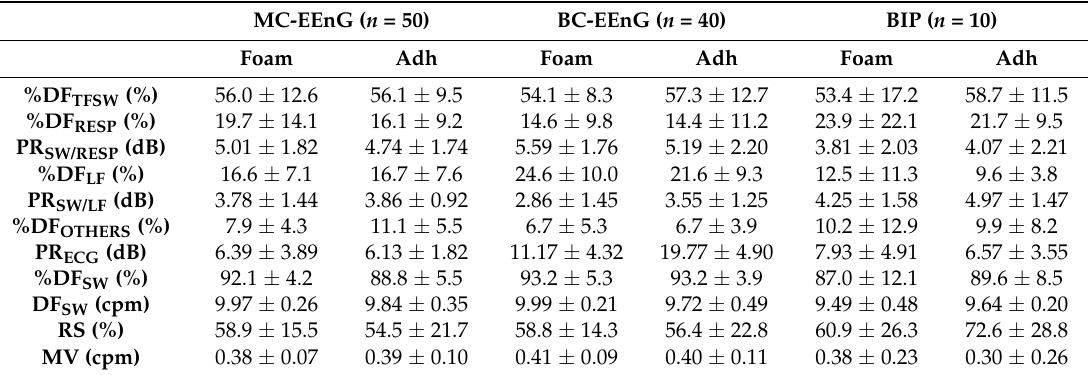
Table 3. Mean and standard deviation of the parameters defined for SW identification and interference quantification of surface abdominal signals picked up with different recording factors. Signals recorded in BN position in 10 volunteers.